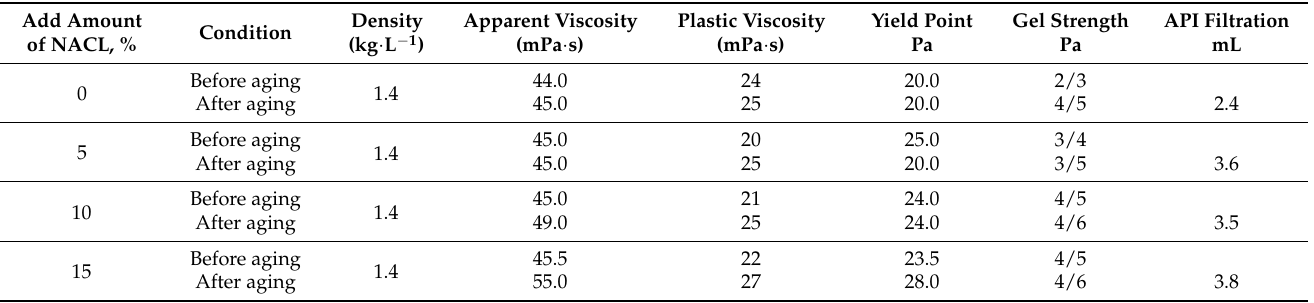
Table 7. Evaluation of Anti-sodium chloride pollution capability between before/after optimization of solid-free organic salt drilling fluid.